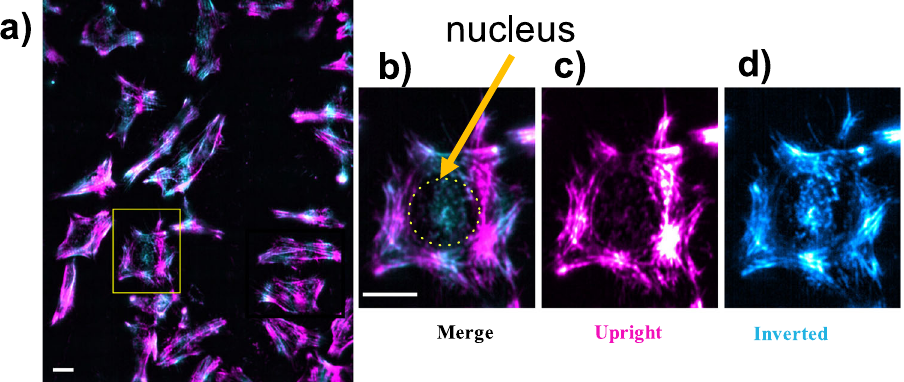
Fig. 5 Comparison of inverted versus upright performance of c-TIRF for imaging actin in fi xed HeLa cells. Cells were imaged on a transparent waveguide using both the ( c, magenta) upright and ( d, cyan) inverted con fi gurations, and the two images overlaid as shown in ( a ); the boxed region in ( a ) is enlarged in ( b – d ). The circled region in ( b ) indicates the position of the nucleus in a yellow dotted circle. With the inverted setup ( d ), more structure is visible under the nucleus than with the upright setup ( c ); this is due to the scattering and refraction of the emitted light as it passes through the bulk of an inhomogeneous sample while travelling to the upright objective, whereas the light only needs to pass through the relatively homogeneous substrate to reach the inverted objective. Both imaging modalities show relatively dark, approximately vertical regions which are due to the mode patterns in the waveguide, but the dark region under the nucleus in ( c ) is broader than can be explained simply by these mode patterns. For all images shown here, 60× 1.2 NA water immersion objectives were used, and 1500 frames each with 50 ms acquisition times were averaged to compensate for the mode patterns. Scale bars are 10 µ